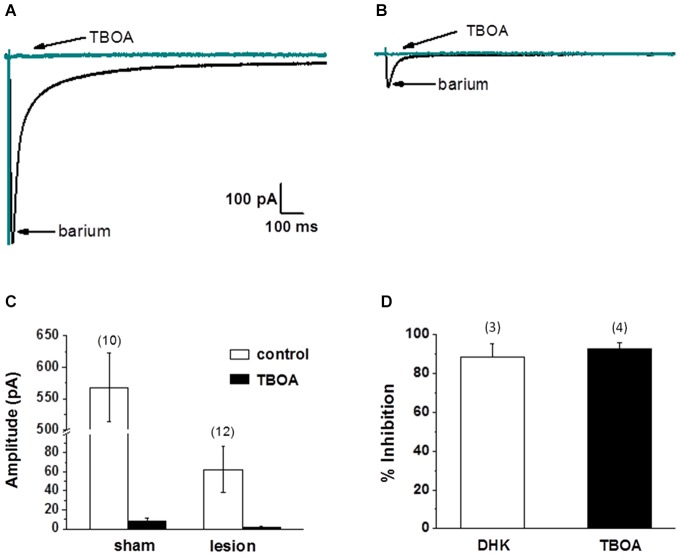
Synaptically evoked glutamate transporter currents (STCs) are markedly reduced in astrocytes in lesioned animals. (A) Specimen records showing evoked responses from a L2/3 astrocyte in a slice from a sham-operated animal following stimulation in cortical L4/5. Responses before and after bath application of TBOA are shown superimposed. TBOA effectively blocked the response. Each trace is average of ten consecutive responses. Experiments were performed in the presence of BaCl2 (100 µM) to inhibit a K+ uptake currents. (B) Similar to A, but from an astrocyte in a slice from a lesioned animal. Specimen records show that responses were smaller in amplitude relative to controls. Responses were TBOA sensitive. (C) Summary plots showing differences in STCs between astrocytes in slices from sham-operated and lesioned animals. STCs were significantly smaller in astrocytes from lesioned slices relative to astrocytes from sham-operated animals. (D) TBOA inhibited 92.8 +/− 3.3% (n = 4) of STC mediated currents while 88.6 +/− 6.7% (n = 3) of current was inhibited by DHK.